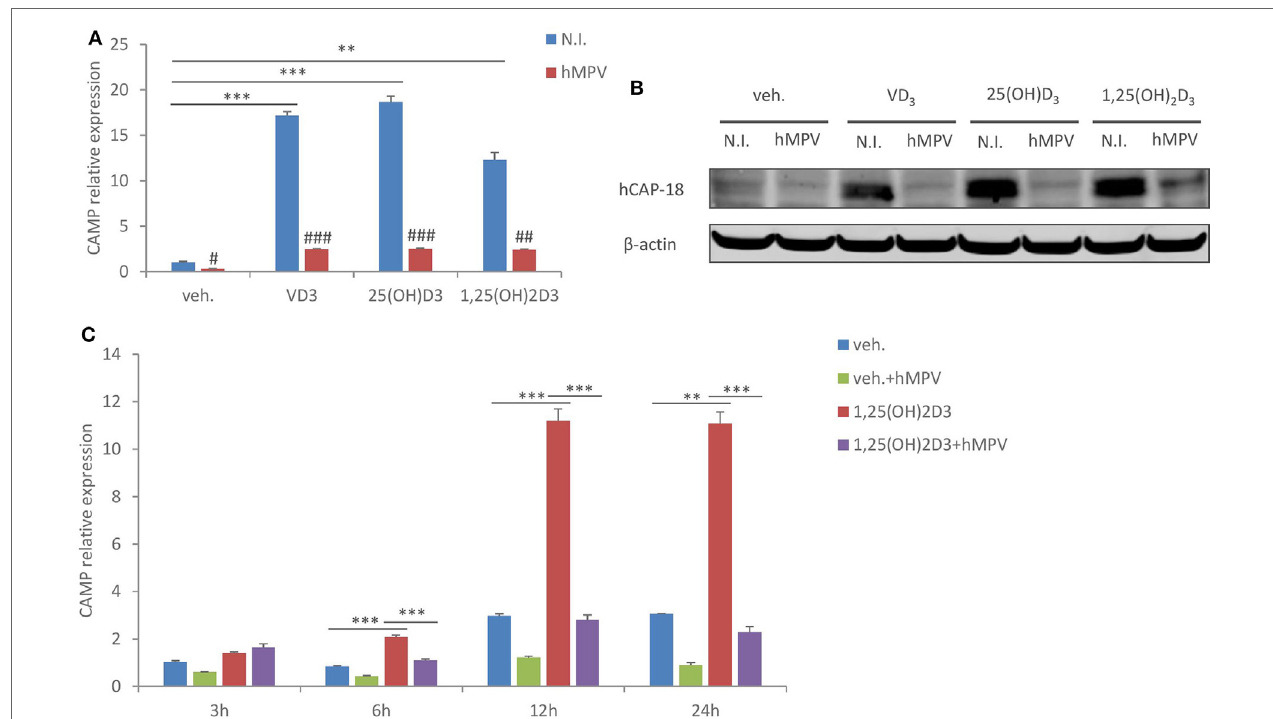
FigUre 1 | Human metapneumovirus (hMPV) infection suppresses cathelicidin antimicriobial peptide (CAMP) expression in human macrophages. (a,B) Monocyte­ derived macrophages (MDMs) were treated with vehicle (veh.) or different forms of vitamin D [VD 3 , 25(OH)D 3 , and 1,25(OH) 2 D 3 ], and concomitantly infected by hMPV or mock­infected by medium [non­infected (N.I.)] for 24 h. CAMP mRNA expression (a) and protein expression (hCAP­18) (B) were assessed by quantitative real­time PCR (qRT­PCR) and immunoblotting. (c) MDMs were treated with veh. or 1,25(OH) 2 D 3 and infected by hMPV or mock infected for indicated hours. CAMP mRNA expression was assessed by qRT­PCR. Error bars represent SD for triplicates. ** p < 0.01, *** p < 0.001; # p < 0.05, ## p < 0.01, and ### p < 0.001 (compared to non­infected samples with the same veh. or vitamin D treatment). Data are representative of at least three independent experiments from different donors. Full­length blots are presented in Figure S1 in Supplementary